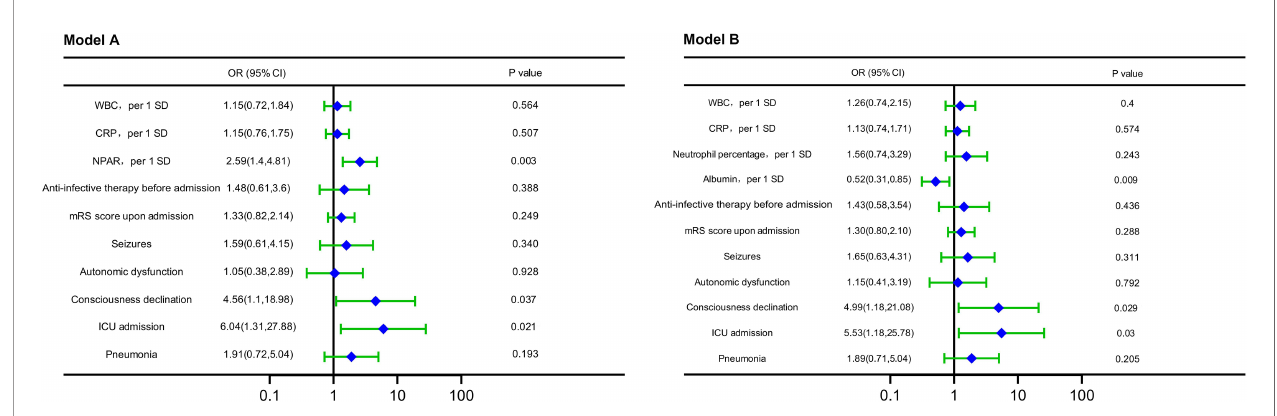
FIGURE 5 | Forest plots of multivariable logistic regression affecting short-term outcome (Model A and Model B). OR, odds ratio; CI, con fi dence interval; WBC, count of white blood cell; SD, standard deviation; CRP, C-reactive protein; NPAR, neutrophil percentage-to-albumin ratio; mRS, modi fi ed Rankin scale; ICU, intense care unit.